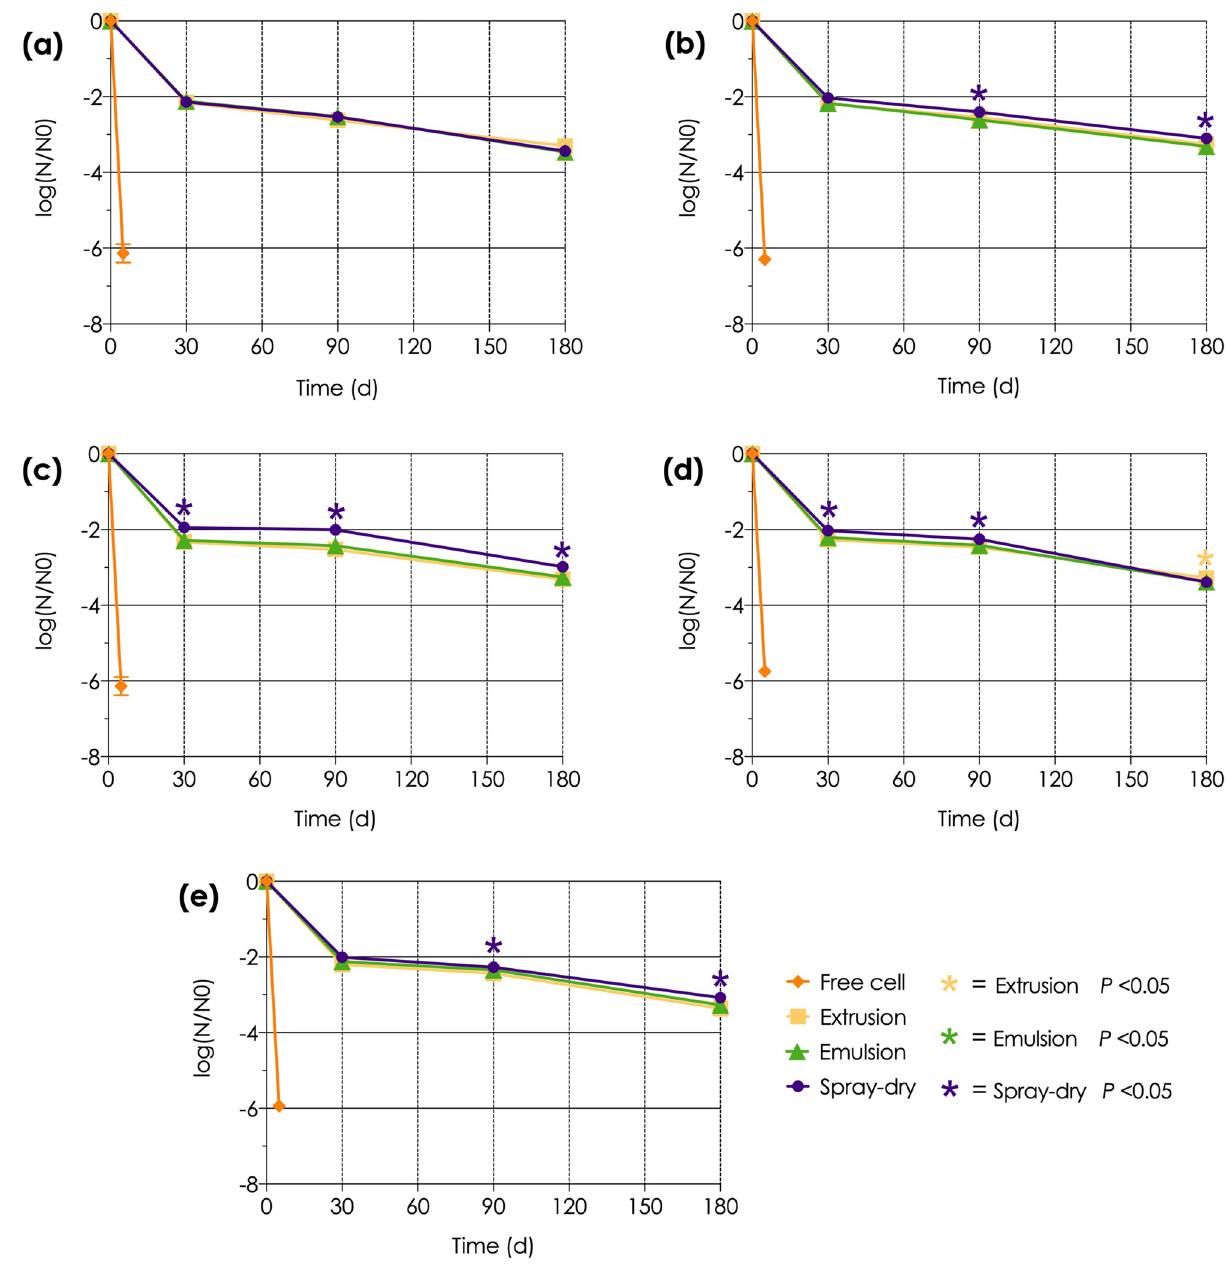
Figure 2. Comparison of the survival level between the non-capsulated and differently encapsulated LAB ( a ) L22F, ( b ) L25F ( c ) L31F, ( d ) P77F and ( e ) P72N strains over 6 months storage at room temperature. The asterisks represent statistically significant differences ( P < 0.05). The yellow, green, and purple asterisks represent the significance of differences for the extrusion, emulsion, and spray-drying methods,